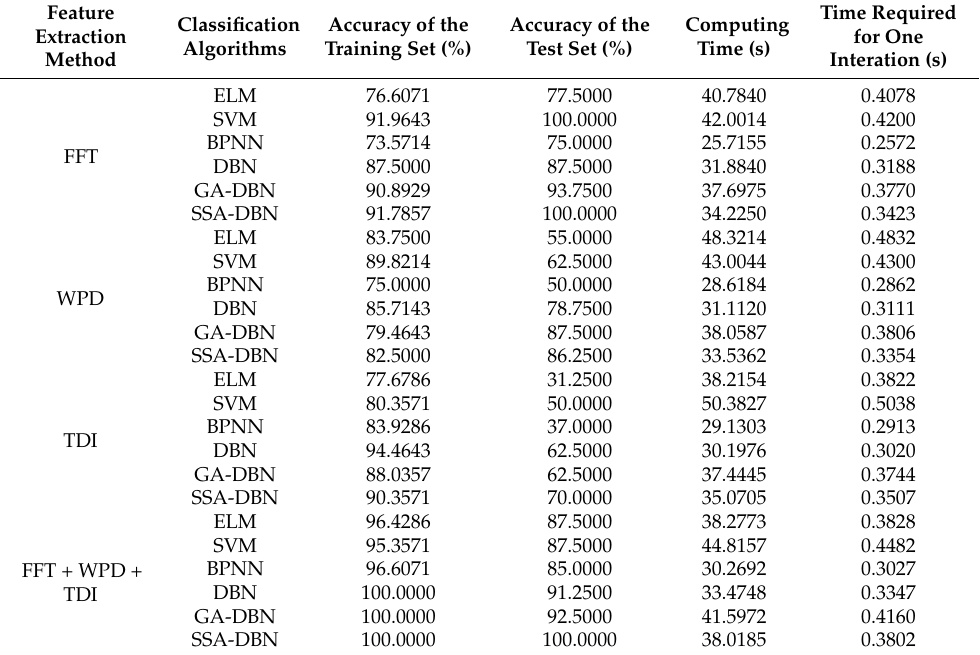
Table 4. Identification results of the no-load